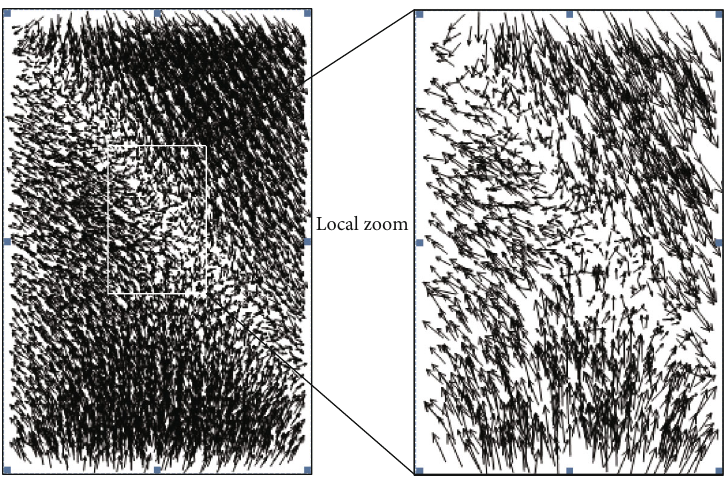
Figure 12: Distribution particle